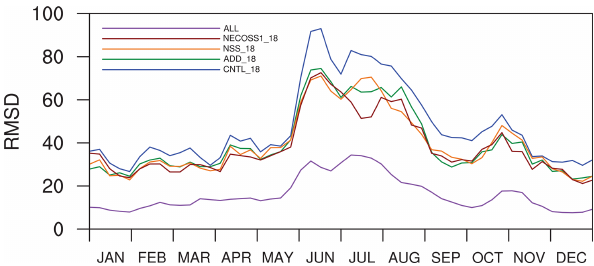
Figure 12. The same as Fig. 4 except for the CNTL_18 (blue solid line), ADD_18 (dark green solid line), NSS_18 (dark orange solid line), NECOSS1_18 (dark red solid line), and ALL (purple solid line)